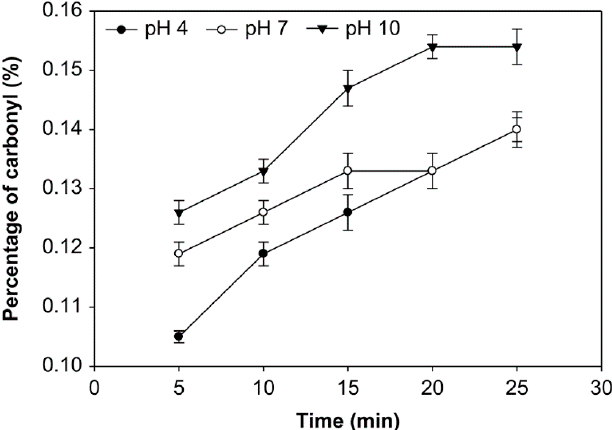
Figure 2. The effect of time on carbonyl group content at various pH and the starch concentration of 20% ( v / w ).